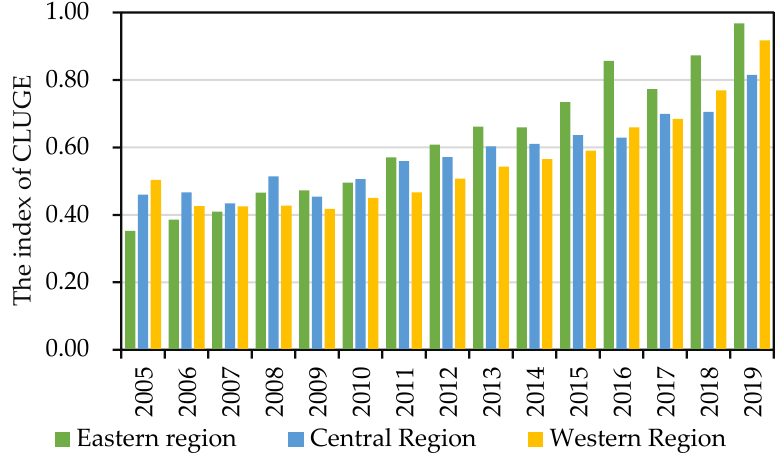
Figure 3. The evolution of CLGUE in China’s three regions.